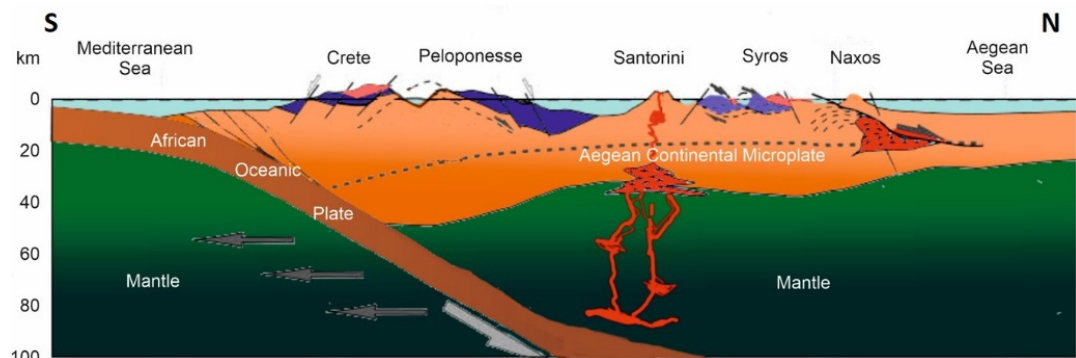
Figure 5. Schematic reconstruction of the northward dipping Hellenic Subduction system (after [68], modified).